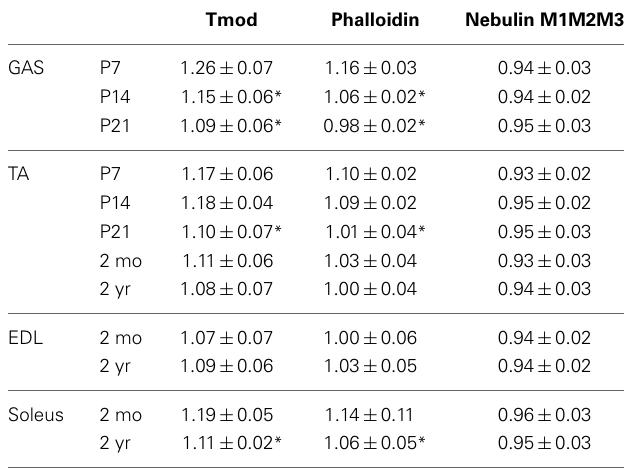
Table 1 | Thin filament lengths determined by Distributed Deconvolution analysis of fluorescence